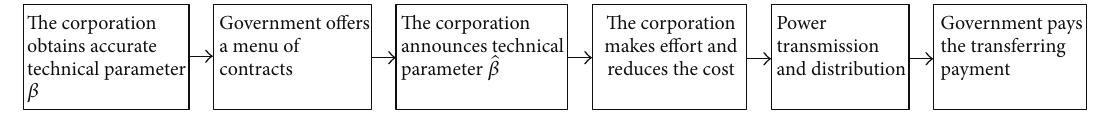
Figure 1: The game sequence between government and the